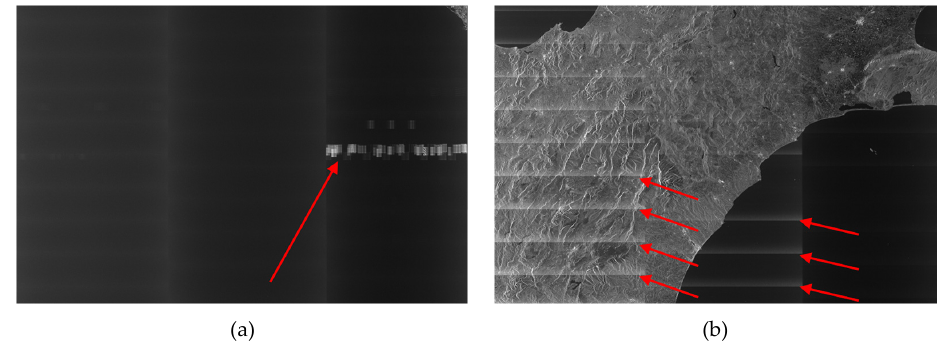
Figure 3 . Example of Sentinel-1 images affected by RFI (radiofrequency interference): ( a ) from ground source (image name: S1A_IW_GRDH_1SDV_20160712T164623_20160712T164648_012118_ 012C3E_5B16); and( b )fromRadarsat-2(S1A_IW_GRDH_1SDV_20150909T165710_20150909T165735_007641_00A97F_B8EB). The VH polarimetric channel is shown in both cases. Azimuth is from top to bottom; range from left to right. The RFI (indicated with arrows) is visible as horizontal rows or short bright vertical stripe artefacts. Sentinel-1 images © Copernicus 2015, 2016.